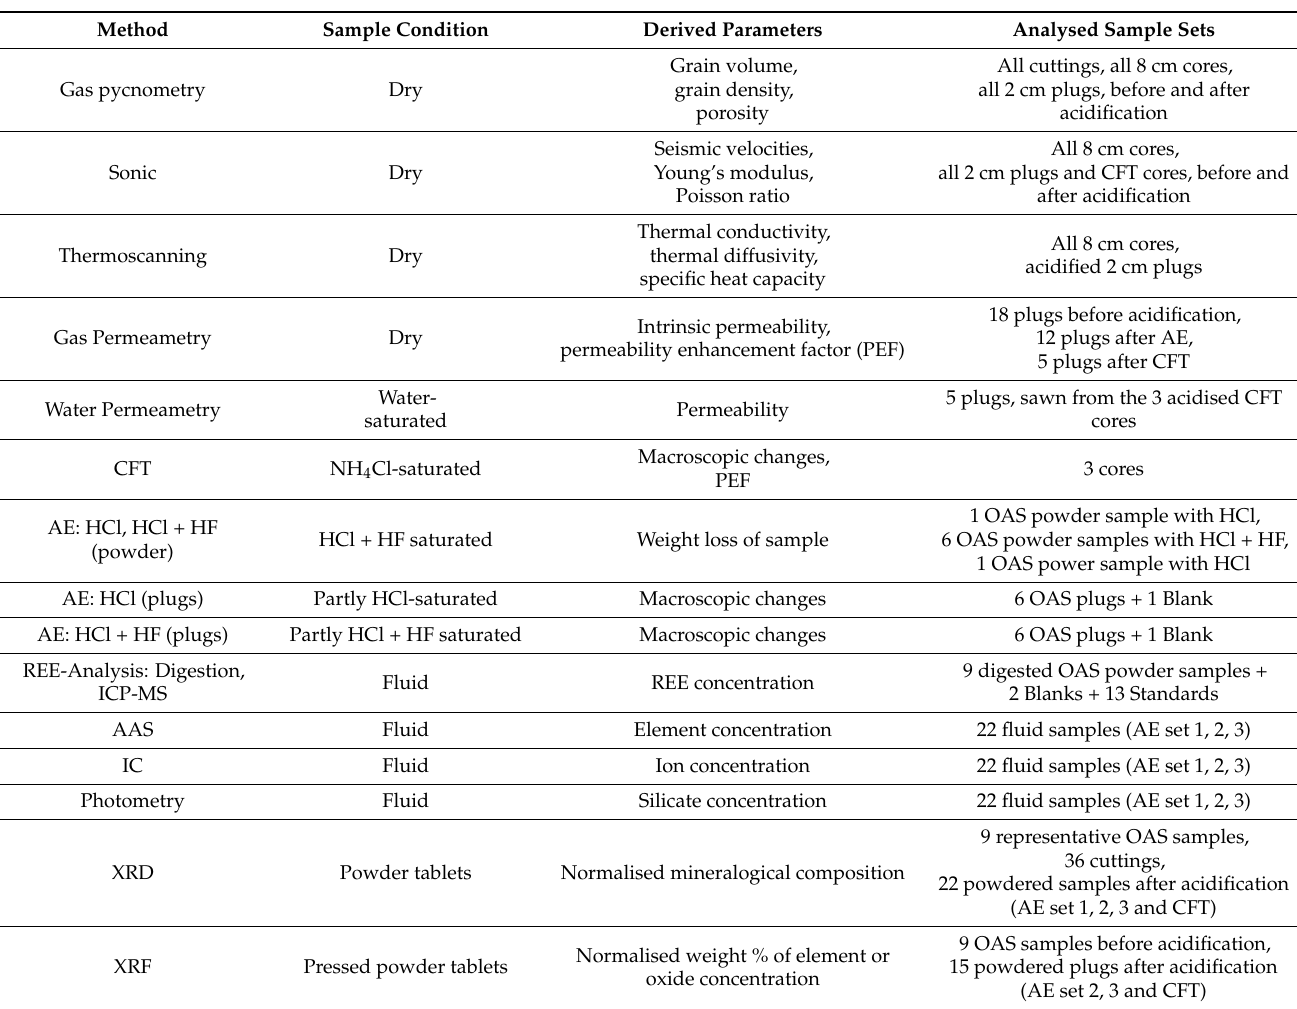
Table 2. Applied methods and analysed sample sets. Abbreviations: CFT = core flooding